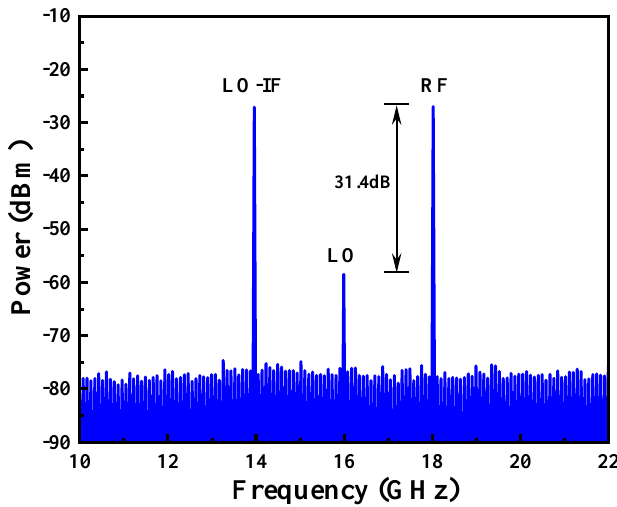
Figure 3. Measured up-conversion electrical spectra of the upper path when the DD-MZM working at the minimum point optical spectra of the upper path before EDFA (RBW = 500 kHz).